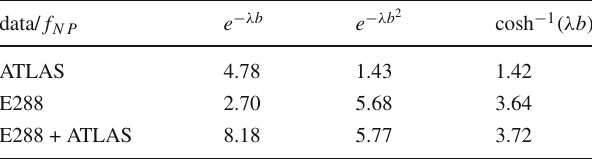
Table 9 The values of χ 2 / d . o . f for different single-parameter non- perturbative functions f NP , minimized on different data sets. The χ 2 / d . o . f values correspond to δ = 0 . 2 and T